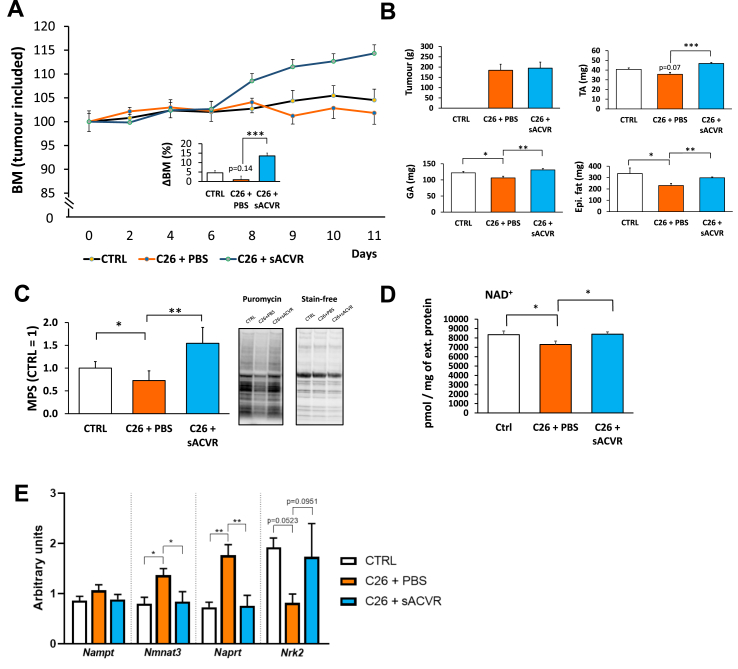
Anti-cachexia treatment after tumour inoculation (experiment 2) reveals increased body mass, muscle masses, and muscle protein synthesis and repleted NAD+. Changes in body mass (BM; A), tissue masses (B), muscle protein synthesis (C), contents of NAD+ (D), and gene expression of the regulators of NAD+ biosynthesis (E) in control mice and in mice treated with sACVR or PBS. Epi. fat = epididymal fat pad. ∗ = P < 0.05, ∗∗ = P < 0.01, and ∗∗∗ = P < 0.001 when using a two-tailed unpaired Student's t test.